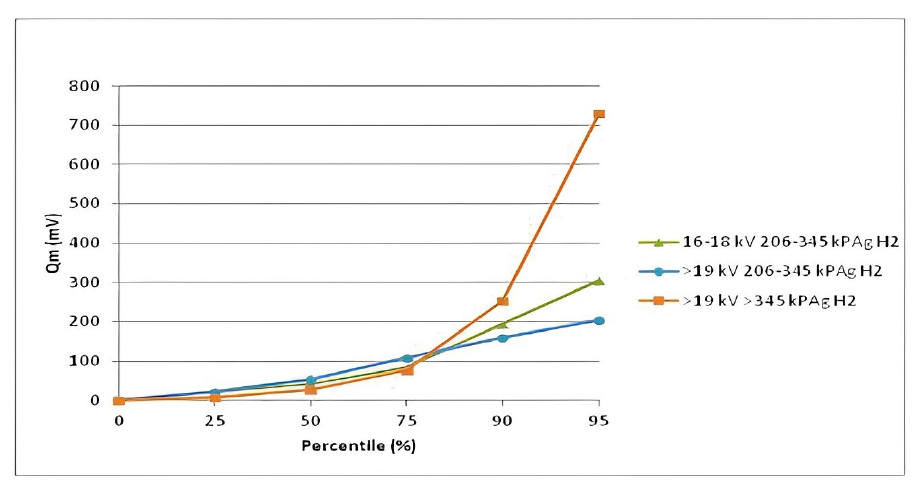
Figure 16. Curves for respective voltage classes [41].